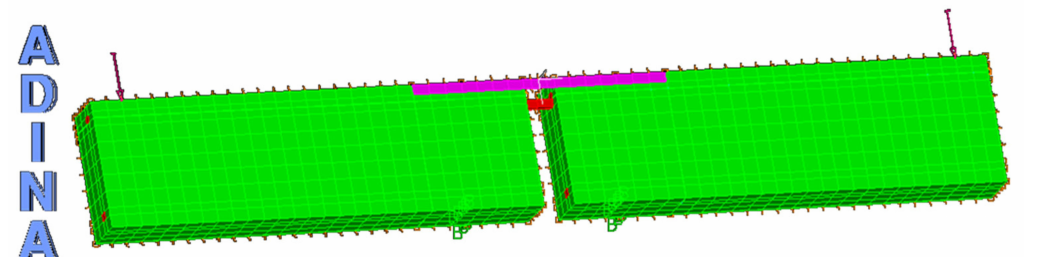
Figure 10. Typical finite element mesh.